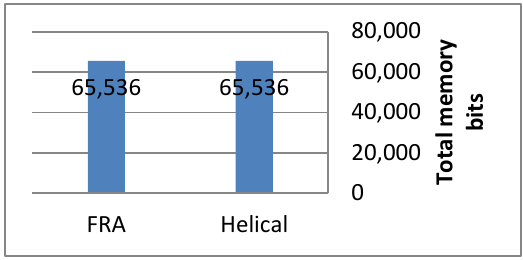
Figure 15. Total number of memory bits required for FPGA implementation of FRF and helical interleavers of size 128 ×